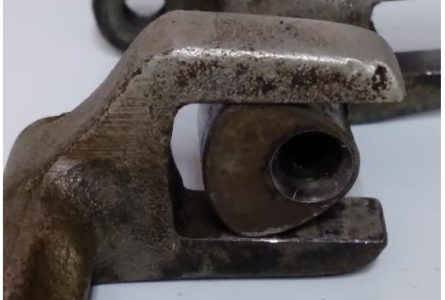
Figure 2. Photograph of the constant-breadth cam mechanism with a flat-faced double-oscillating follower, used in a traditional sewing